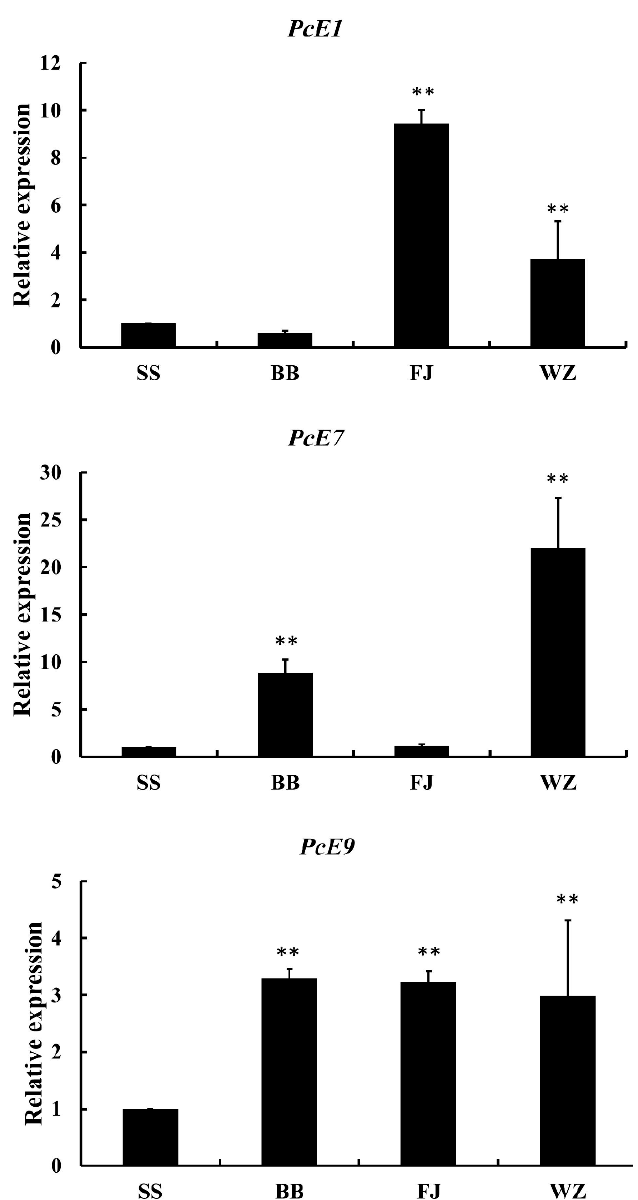
Figure 3. Expression patterns of PcE1 , PcE7 and PcE9 in different populations. Relative expression levels were calculated based on the control (SS), which was defined as a basal value of 1. The vertical bars indicated standard errors of the mean ( n = 3). The asterisk on the vertical bars indicate significant differences in the mRNA level of between control and treatment (Student’s t -test, ** p < 0.01).